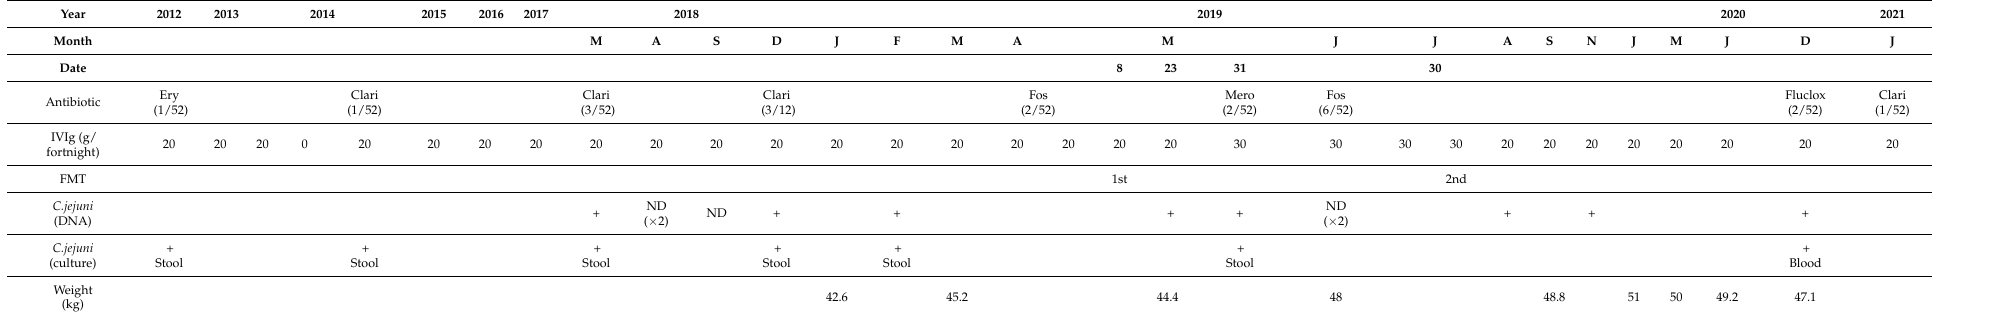
Table 1. Timeline of events from time of first episode of Campylobacter enteritis to death in January